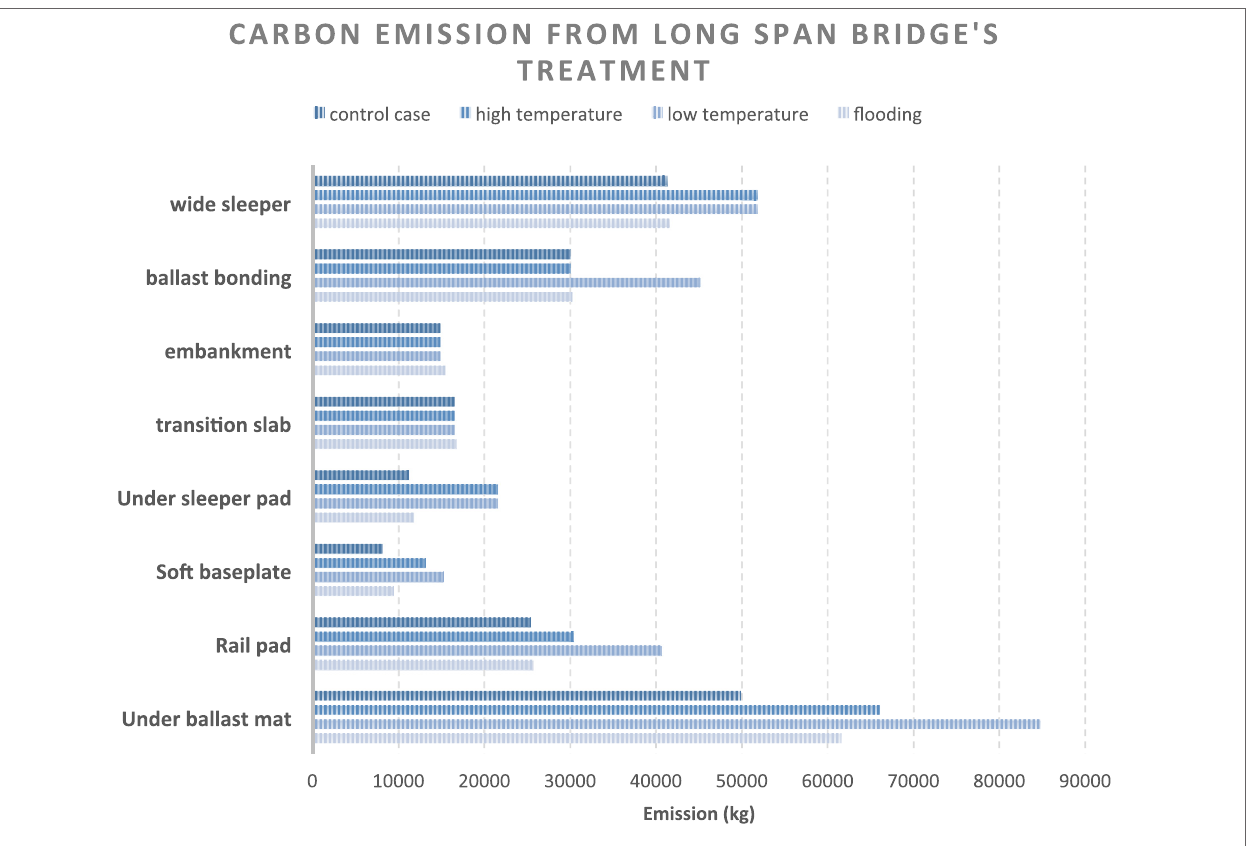
Figure 7 | Carbon emission from long-span bridge approach treatment and maintenance in different